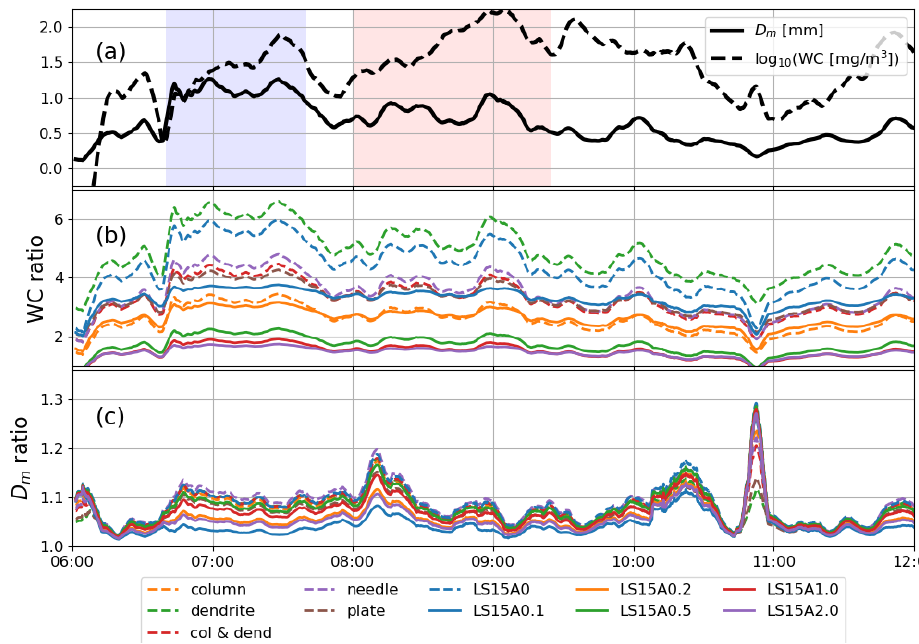
Figure 6. (a) Derived D m and WC (in log units) for the rain DSD just below the melting zone. (b) Relative change of the WC when passing from rain to ice, i.e., WC ice / WC rain . (c) The same as panel (b) but for D m , i.e., D ice m /D rain m . Different colors correspond to different ice models as indicated in the legend. Dashed lines correspond to unrimed aggregates, and solid lines denote rimed particles. Blue and red shading indicates aggregation- and riming-dominated periods, respectively.